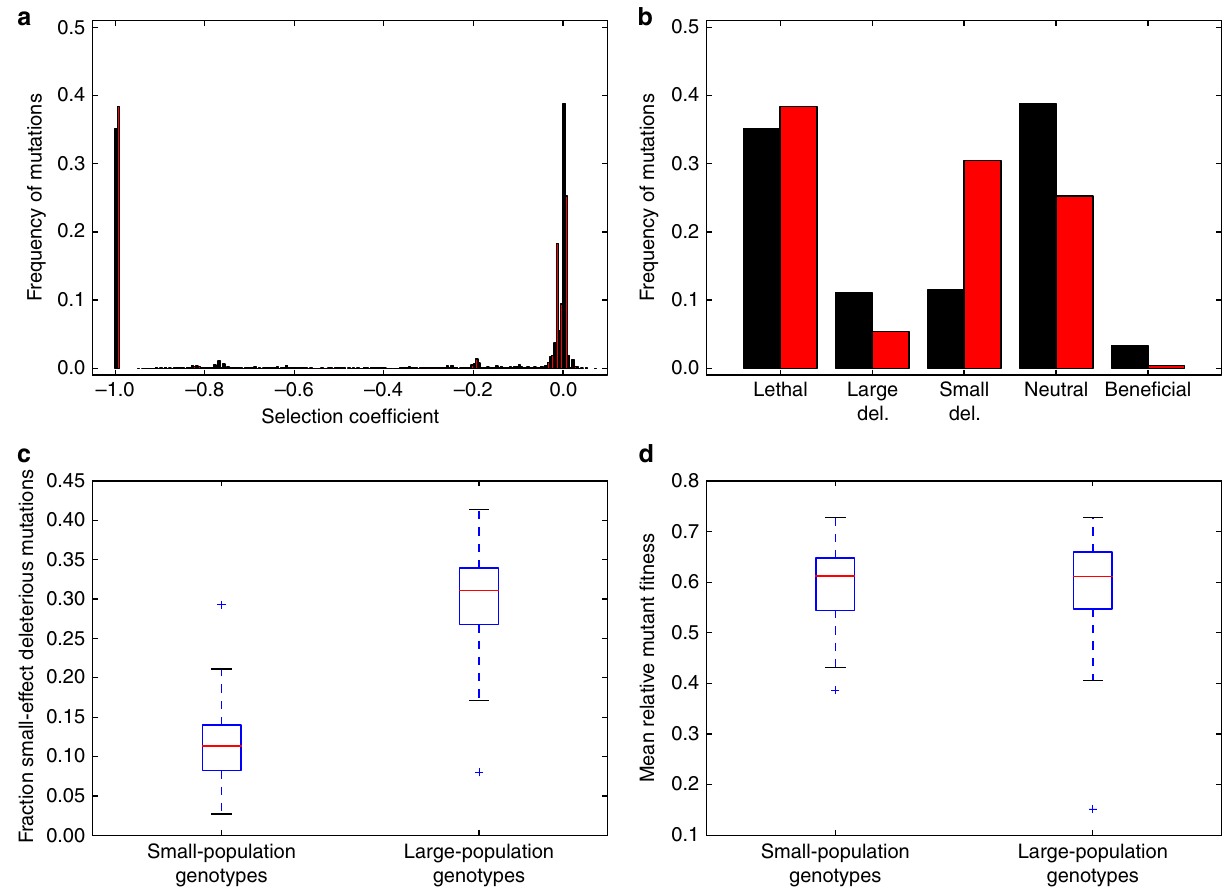
Fig. 4 Differences in mutational effects between small-population genotypes and large-population genotypes. Black and red represent small-population and large-population genotypes, respectively. a The combined distribution of fi tness effects (DFE) across all 100 small-population genotypes and 100 large- population genotypes. b Same data as in panel a, but grouped into different classes of mutations, where a small-effect deleterious mutation is de fi ned as having an effect less than 5%. Here, and throughout, deleterious mutation refers to viable deleterious mutations, while lethal mutation refers to non-viable deleterious mutations. c The likelihood of a small-effect deleterious mutation for small-population and large-population genotypes. Red lines are medians, edges of the box are fi rst and third quartile, whiskers are at most 1.5 times the interquartile range, and the plus signs are outliers. d The mean relative fi tness of every possible point mutation (1250 mutations) for each